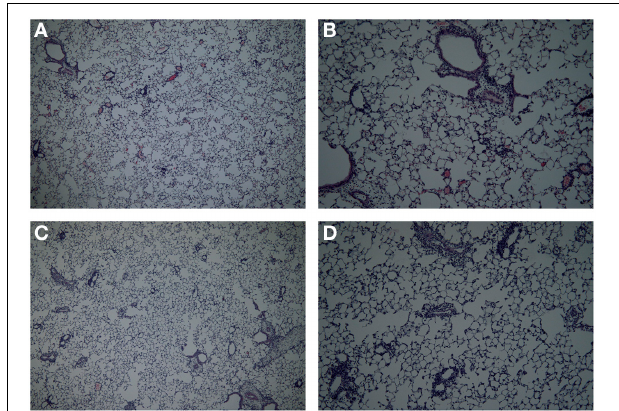
FIGURE 7 | Lung histology in the mild airway inflammation model. Lungs were stained with H and E for histomorphometric analysis of the inflammation in mice sensitized with ovalbumin and challenged by aerosol with ovalbumin (mild) after Penh (A,B) or resistance measurement (C,D) . Magnification 40 × (A–C) or 100 × (B–D)